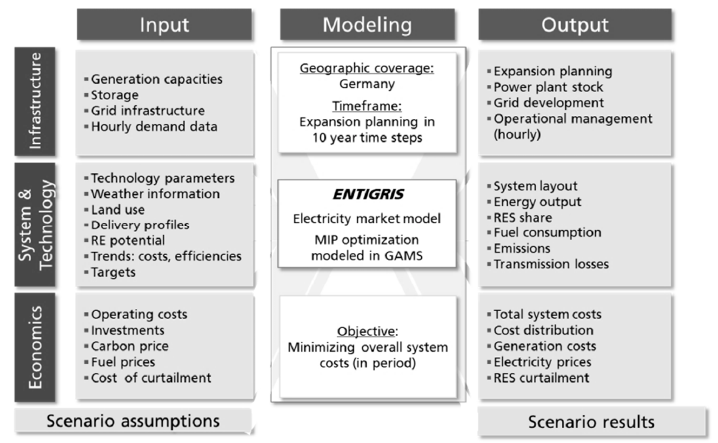
Figure 2. Simplified scheme of the ENTIGRIS power system model [35].